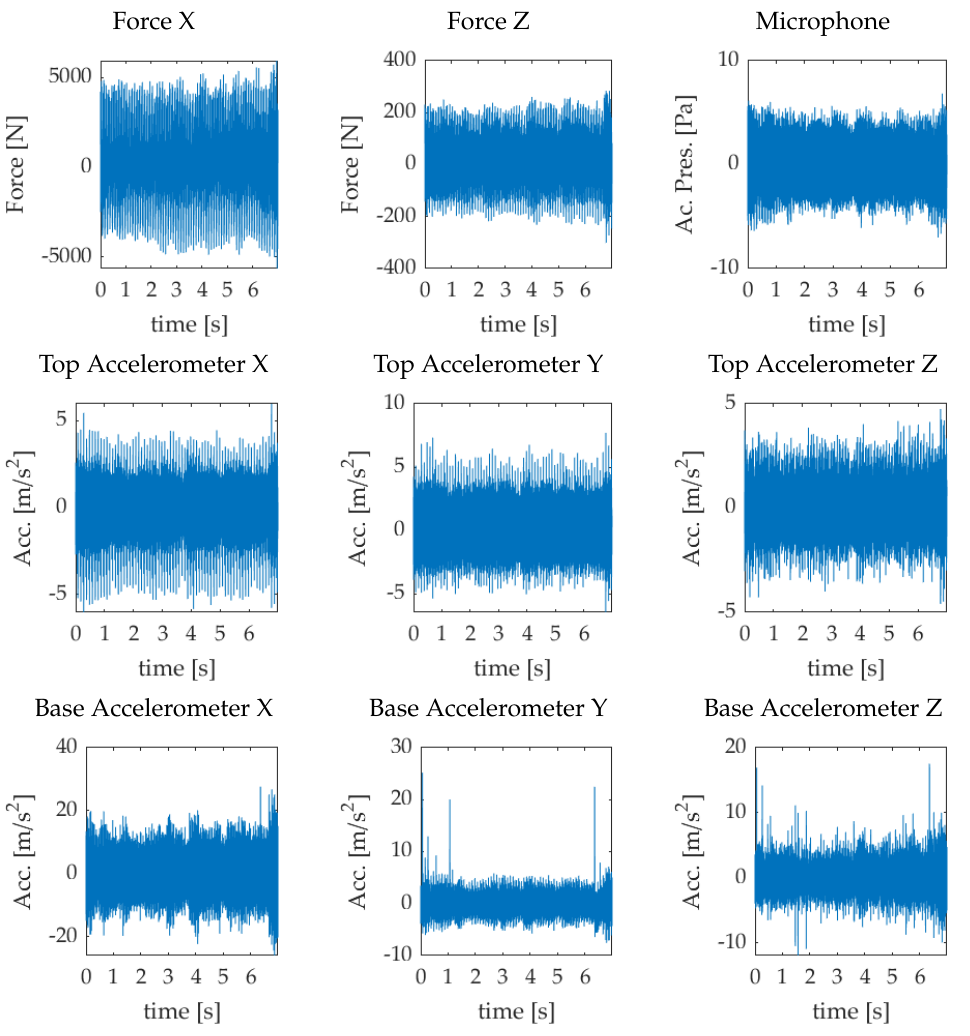
Figure 8. Signals acquired during chatter